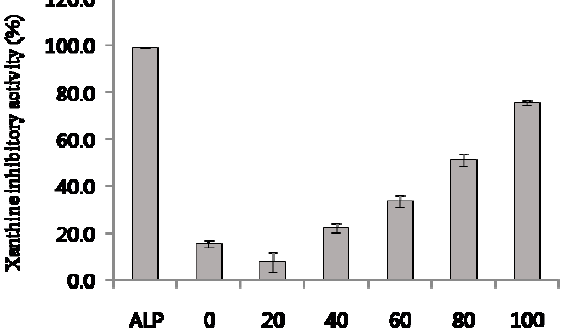
Figure 5. Xanthine oxidase (XO) inhibitory activites of ethanolic extract from C. tricuspidata leaves. ALP: allopurinol (50 µ g/mL); 0–100 on x -axis: 0–100% ethanolic extract (2 mg/mL). Each value was the mean ± SD ( n = 3).